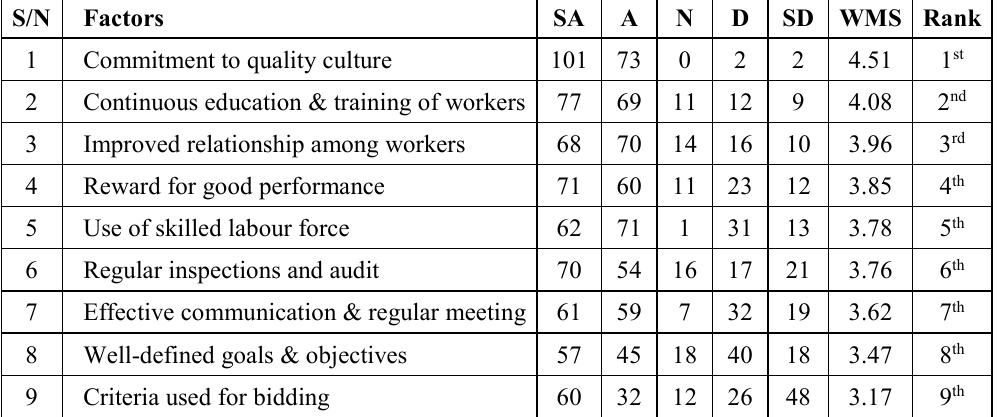
Table 5. Project Managers’ Procedure in Ensuring Quality in Housing Delivery